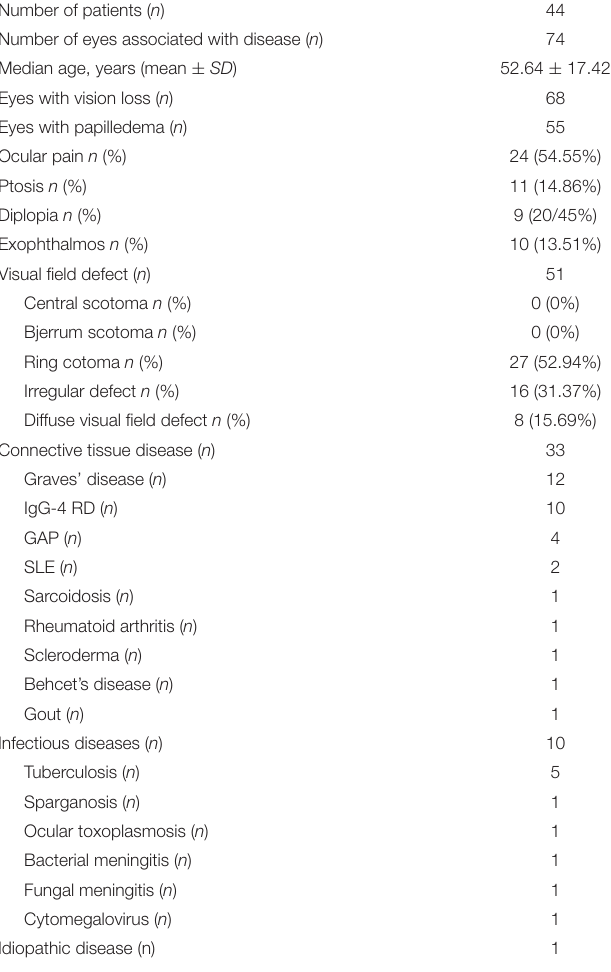
TABLE 1 | OPN patient demographics and clinical characteristics.